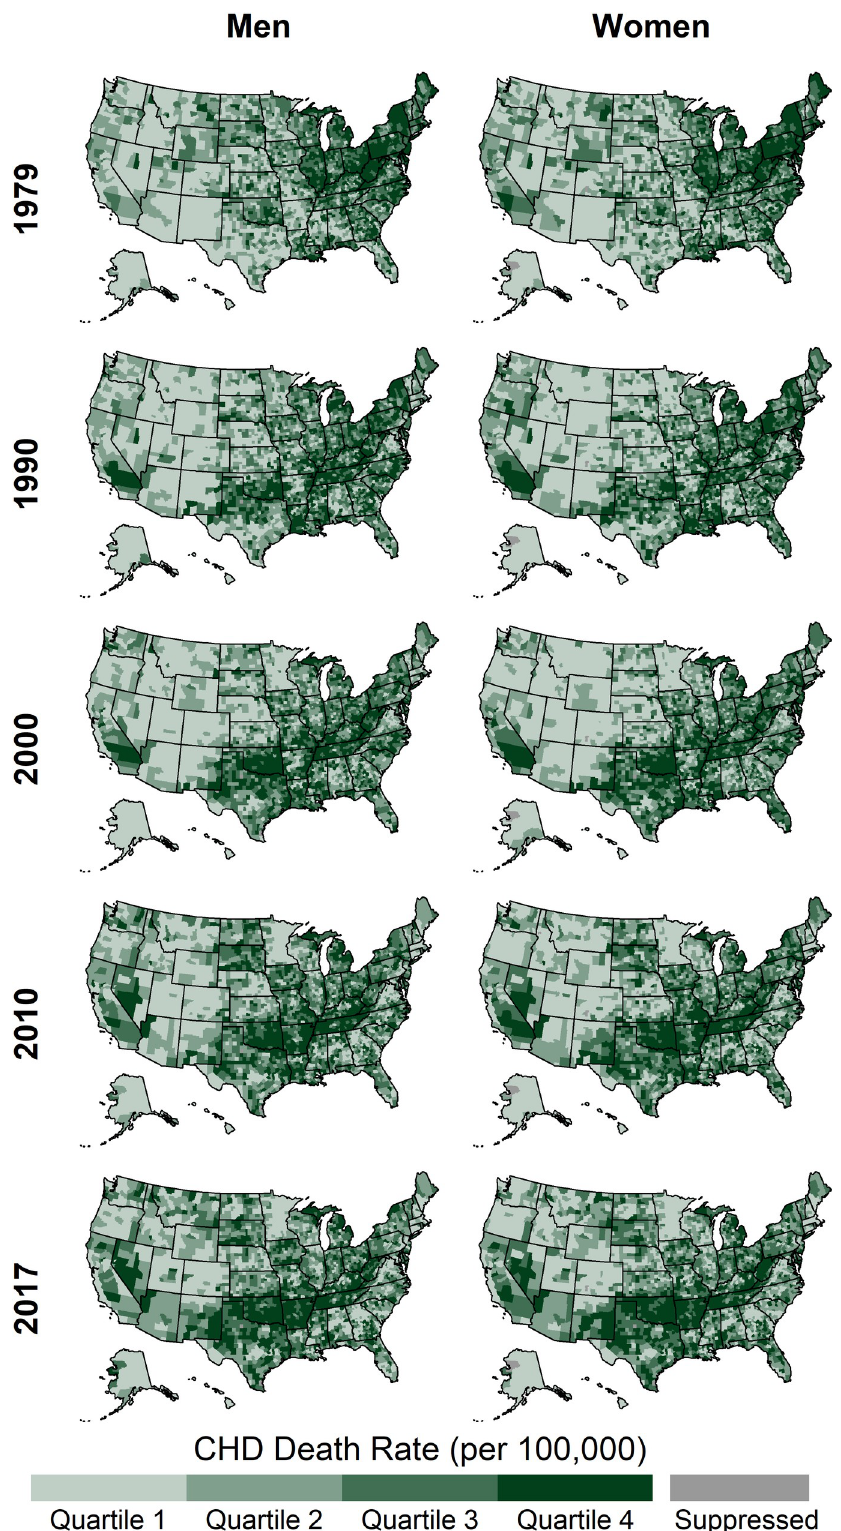
Fig 8. County-level CHD death rates by year and gender, ages 35 and older, United States, 1979–2017. Quartile ranges are shown in Table 2.